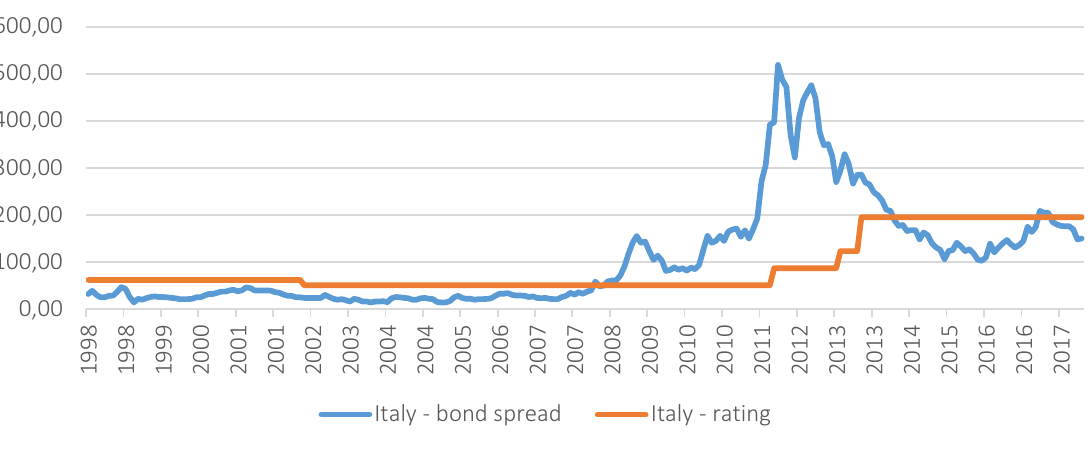
Figure 1. Bond market spread and rating-based spread (in BP) of Italian government bonds (1998 and